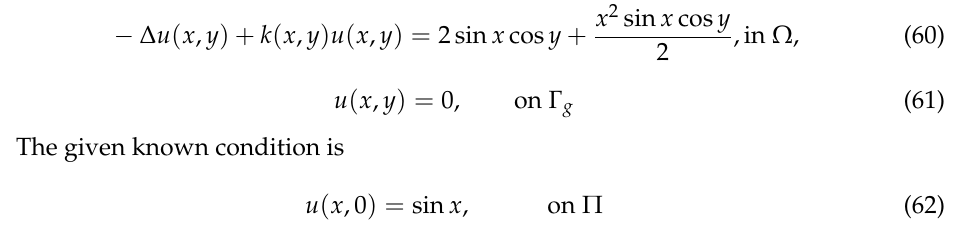
Figure 12. Variation of wave number k with iteration steps for the 2D constant parameter identification problem in irregular geometry.